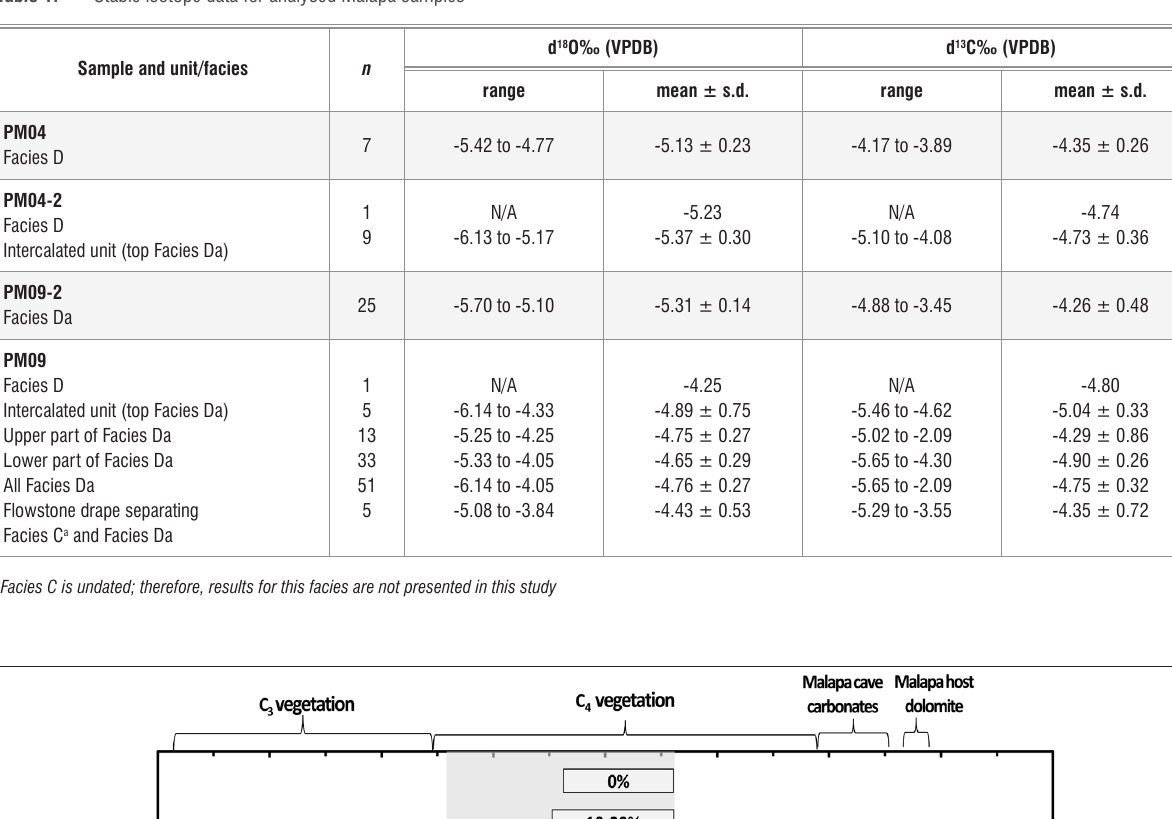
Stable isotope data for analysed Malapa samples